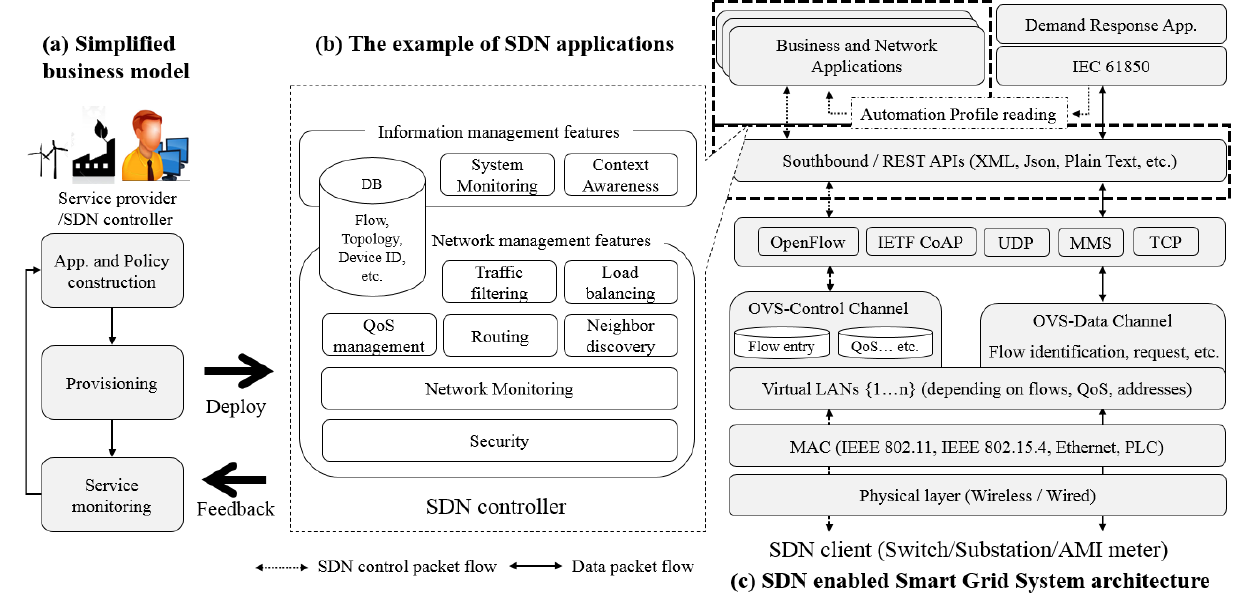
Figure 4. Abstraction of the SDN-enabled smart grid: business model process, categorized SDN application and system architecture. OVS, Open vSwitch; PLC, powerline communication. ( a ) Simplified business model. ( b ) The example of SDN applications. ( c ) SDN enabled Smart Grid System